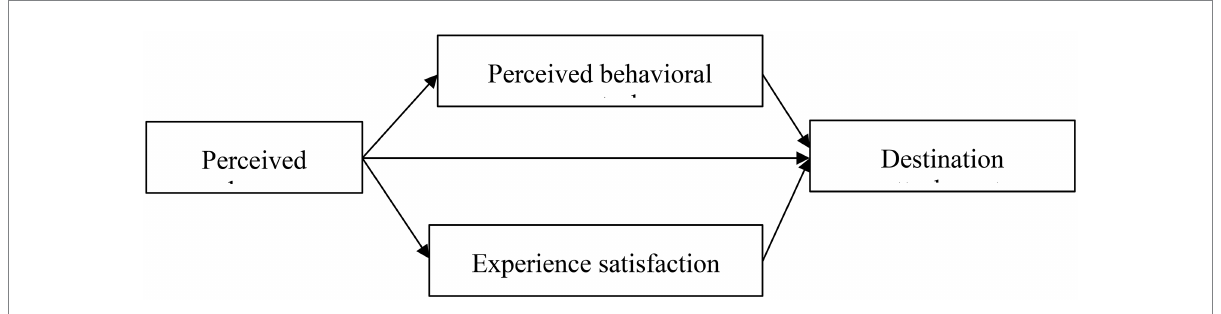
FIGURE 1 Conceptual framework for perceived change and destination attachment.